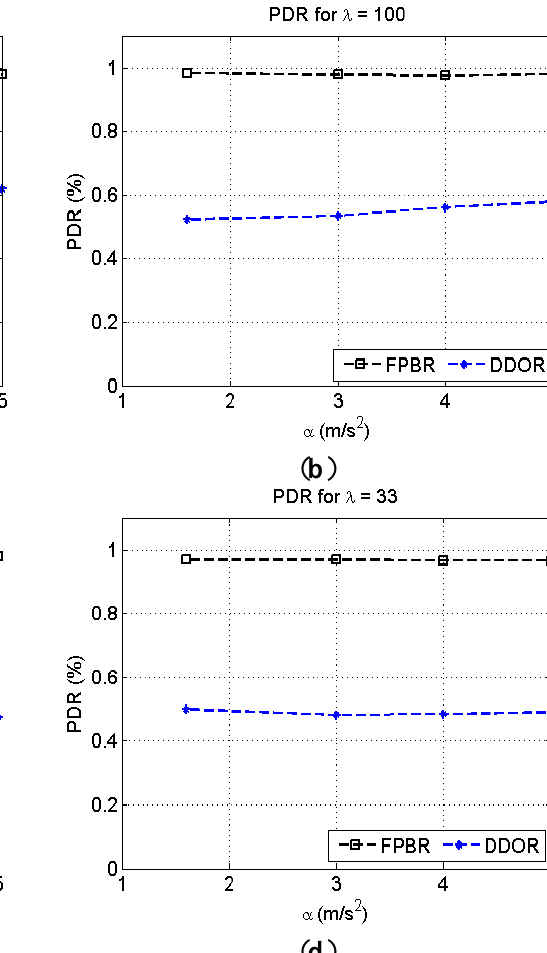
Figure 10. Packet Delivery Ratio (PDR) obtained with FPBR and DDOR when increasing the maximum acceleration, . Four different vehicle densities, , were considered for these plots. Each plot shows the PDR vs. α for: ( a ) λ = 133; ( b ) λ = 100; ( c ) λ = 66 and ( d ) λ = 33.